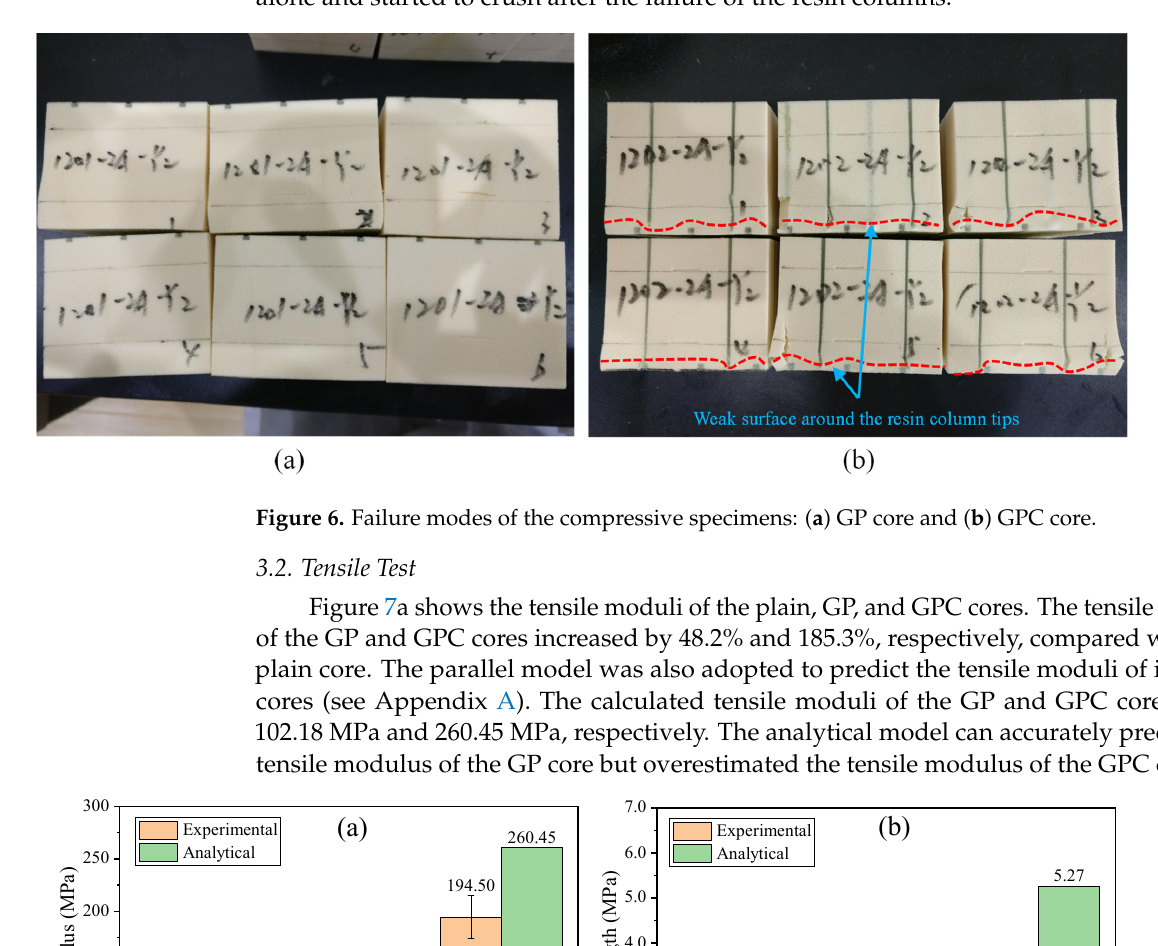
Figure 5. The compressive properties of the plain, GP, and GPC cores: ( a ) modulus, ( b ) strength, and ( c ) strain at peak load.